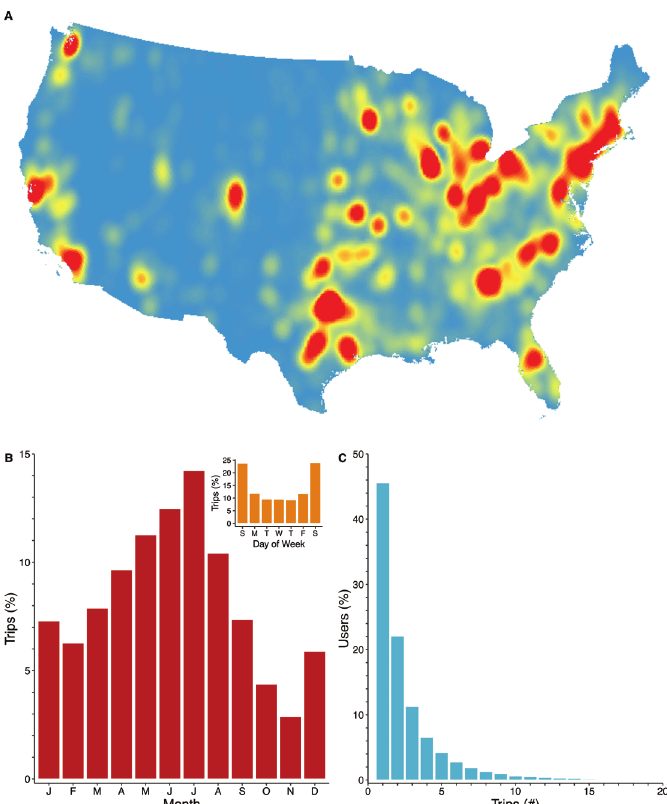
Figure 1. From January 2017 through December 2018 A trip density across the continental U.S. rang- ing from zero (blue) to 1,523 (red) trips per km 2 B percentage of trips by month and (inset) day of the week and C iBobber users (%) by total number of trips taken, truncated at 20 trips (bin size =1).